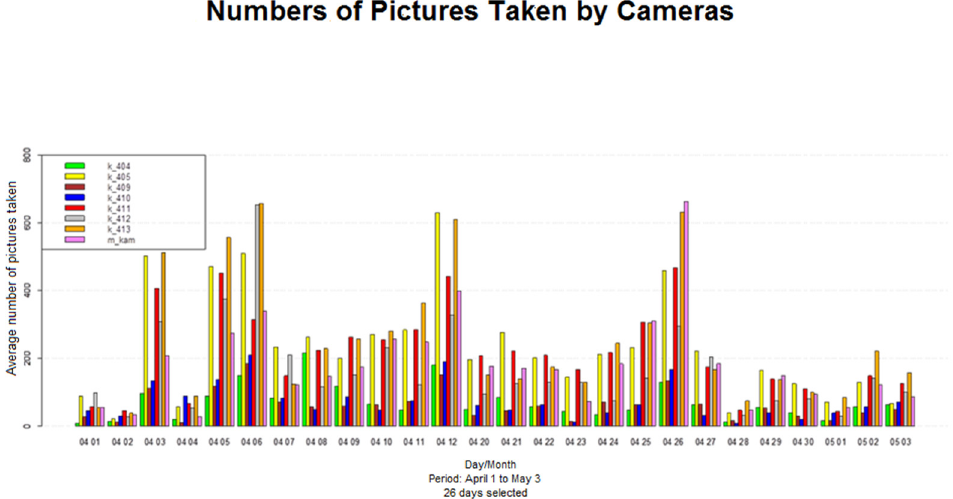
Figure 11. Daily numbers of pictures taken by the cameras at the eight different monitoring points in both monitored forests in Freising, Bavaria, Germany. For color codes and locations of the camera traps, see Figures 1 and 2, and Appendix A, Table A1,